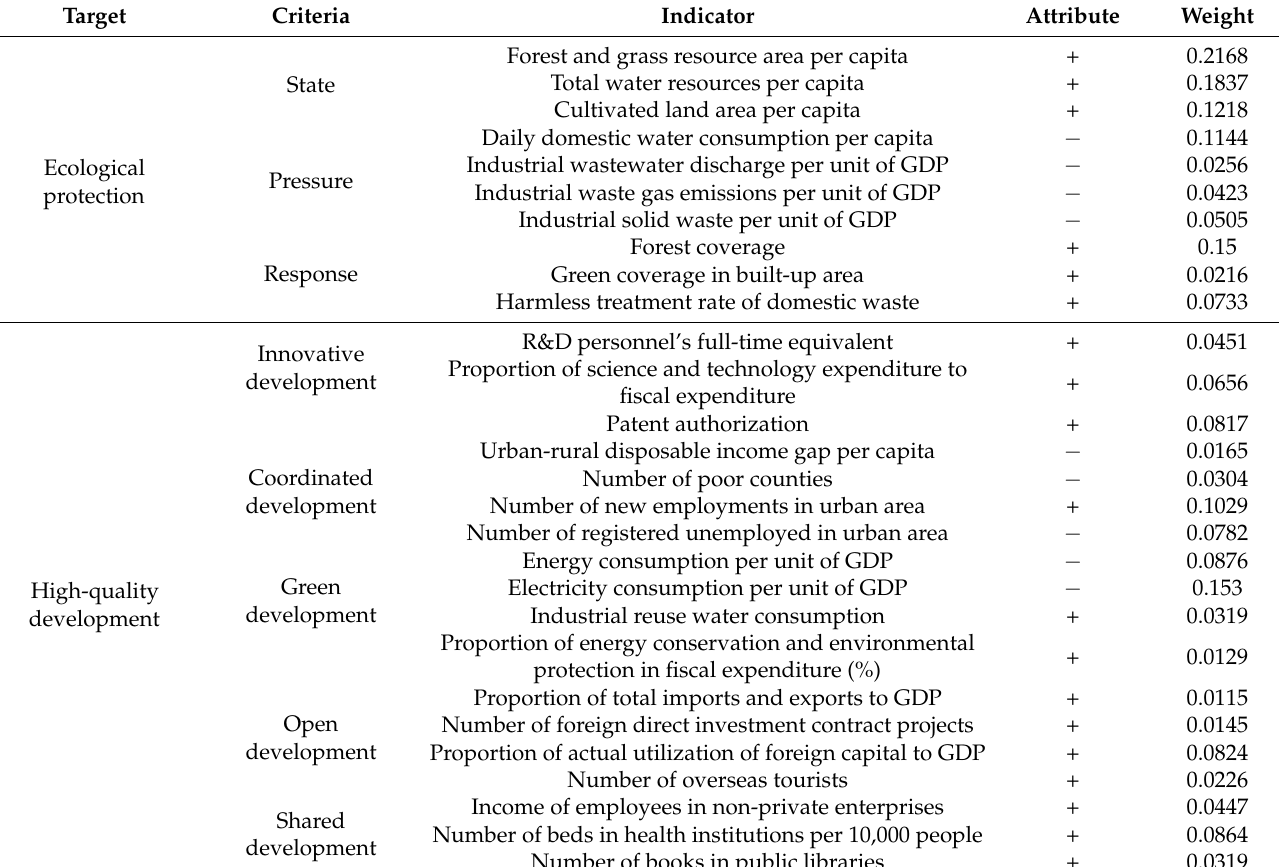
Table 1. Index system of ecological protection and high-quality